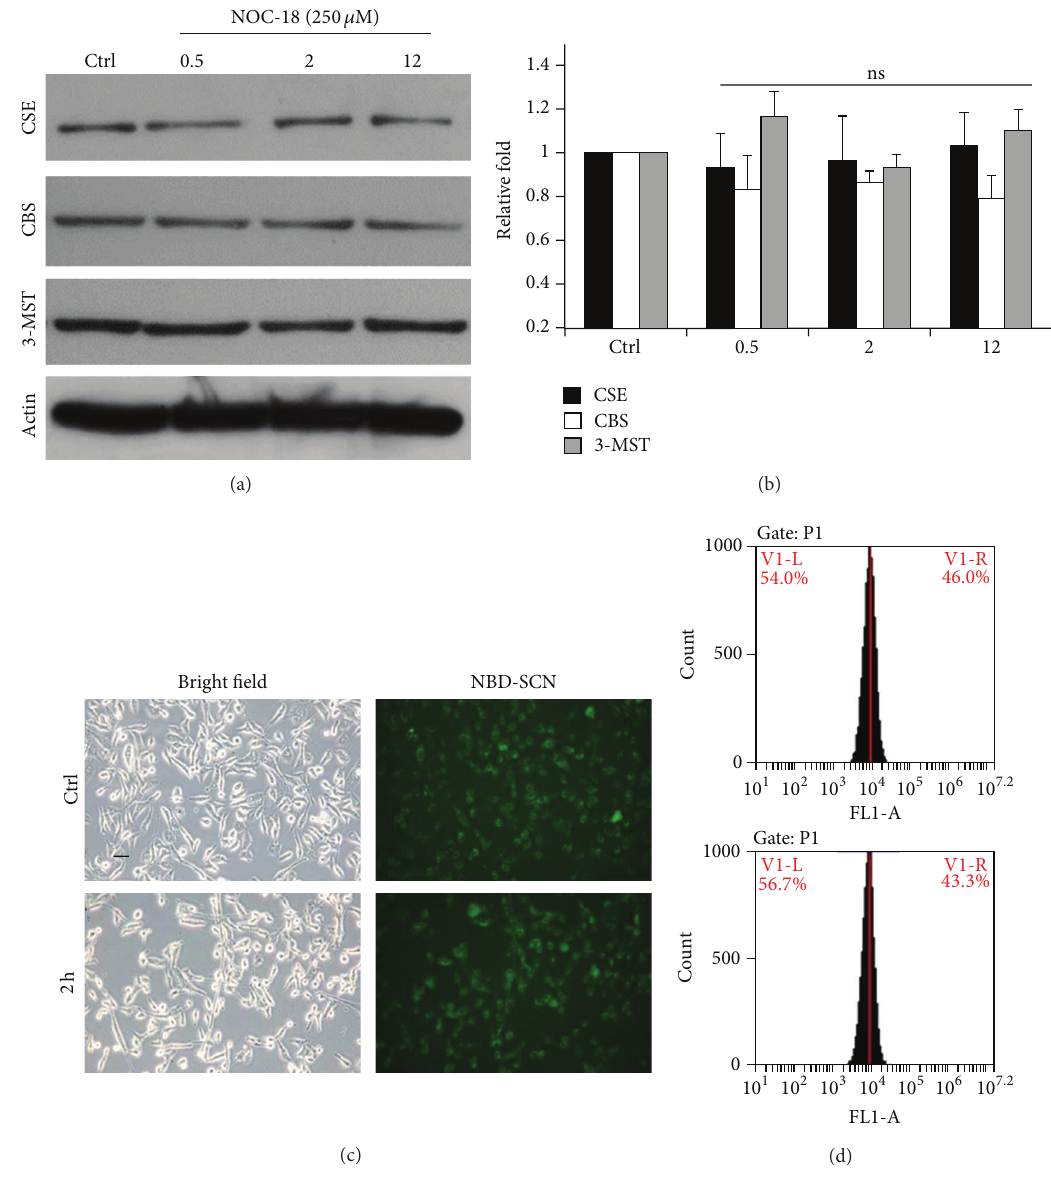
Figure 5: Investigation of H 2 S biosynthesis under the treatment of NO. (a) ECs which treated NO donor, NOC-18 (250 𝜇 M), for 0.5, 2, and 12h were subjected to western blot analysis with CSE, CBS, and 3-MST antibodies. (b) The statistic data showed that no significance ( 𝑃 = ns) was observed between treatments. (c) NBD-SCN was applied to detect cellular H 2 S level specifically. (d) Fluorescent signals were calculated by flow